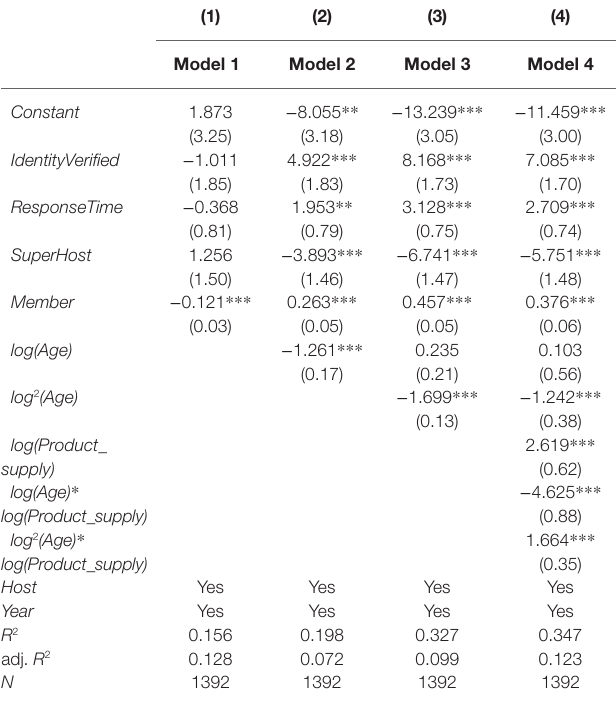
TABLE 3 | Main regression result.